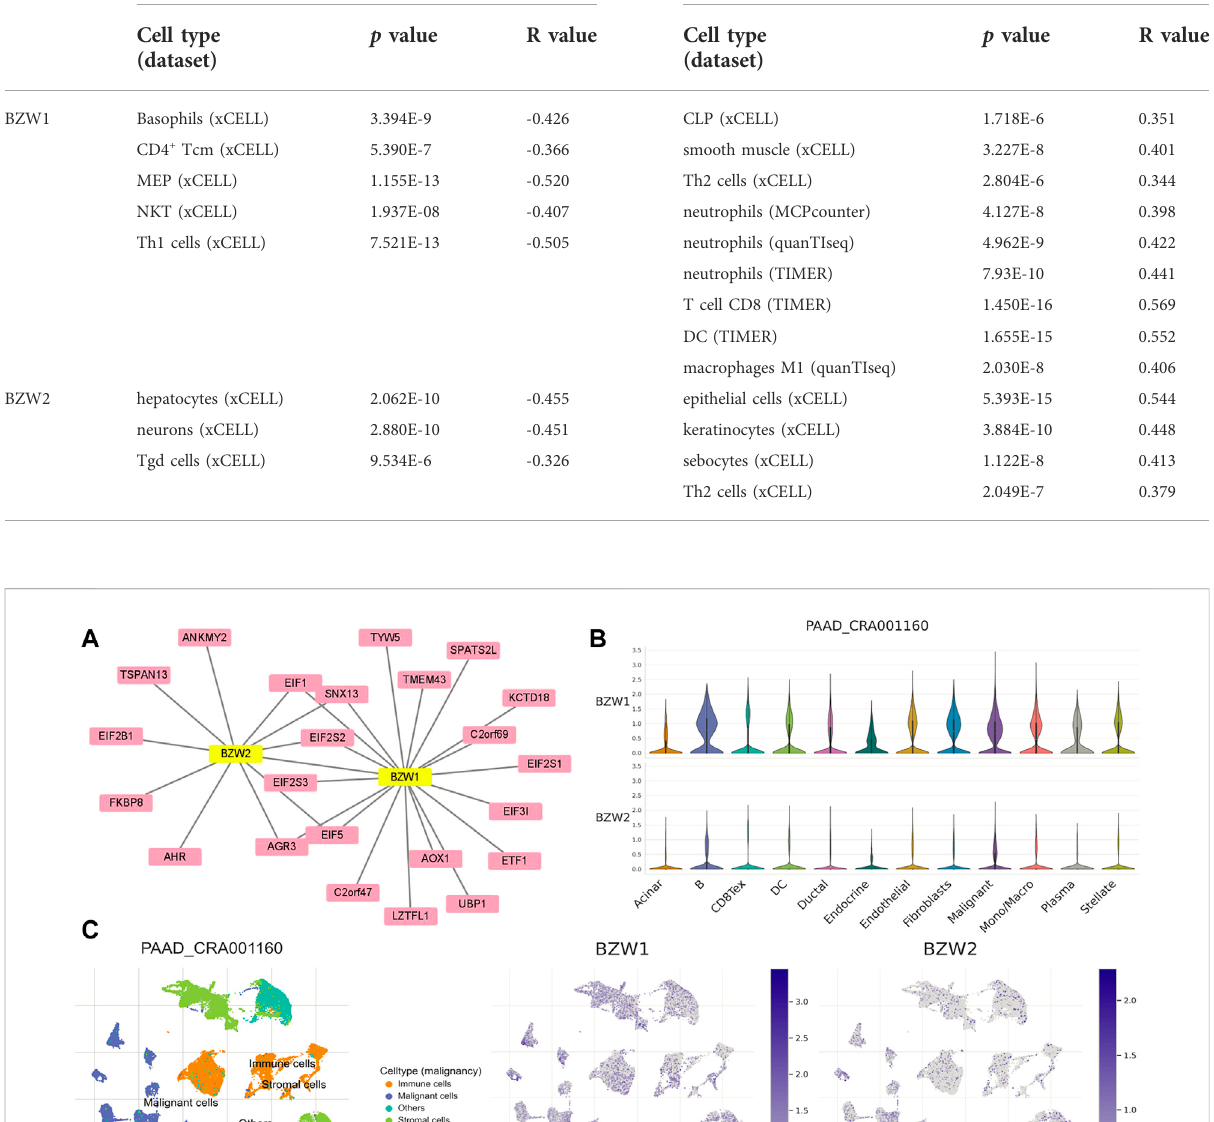
Supplementary Table S6. The expression of BZW1 and BZW2 showed no signi fi cant associations with age, gender, tumor location, differentiation, T stage, N stage, chemotherapy and radiotherapy. Survival analyses indicated